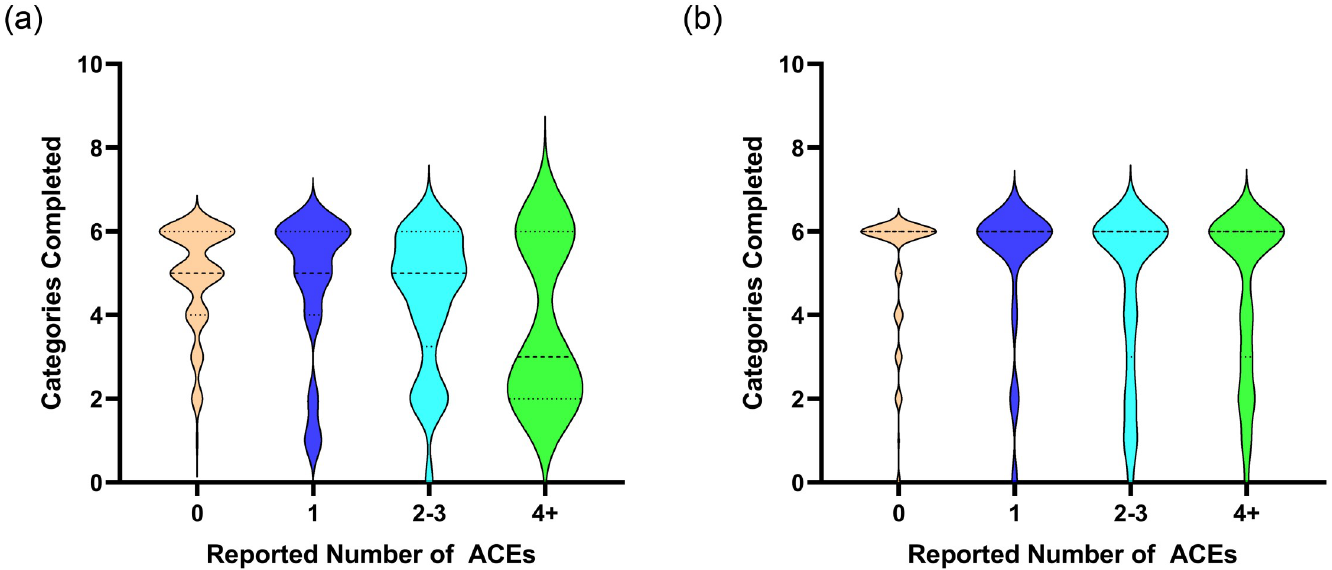
Fig 1. Distributions for the college sample (a) and online adult sample (b) of completed categories for individuals reporting 0, 1, 2–3, and 4+ ACEs before the age of 18. The center of each distribution is identified by the median, which can be identified by the thicker line with larger dashes. The 25 th and 75 th quartiles can be identified by the thinner lines with smaller